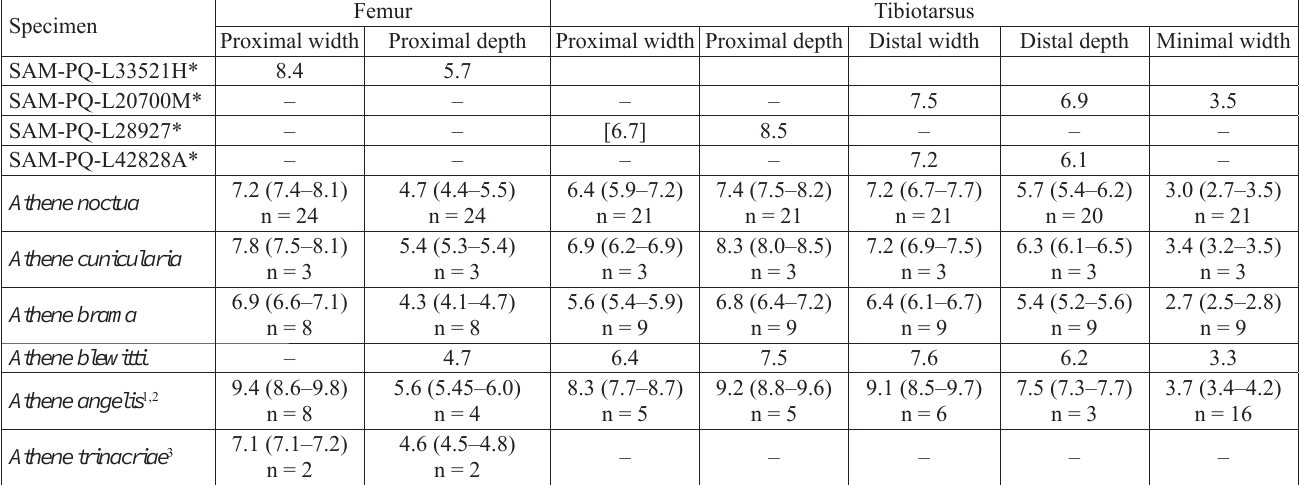
Table 6. Measurements (in mm) of femur and tibiotarsus of Athene inexpectata sp. nov. from Langebaanweg compared with the corresponding bones of various living and fossil Athene species. Measurements of slightly worn or damaged bones are given in square brackets. Paratypes are indicated by an asterisk; 1 measurements after Mourer-Chauviré et al. (1997); 2 measurements after Louchart (2002); 3 measurements after Pavia and Mourer-Chauviré (2002); n, sample size.